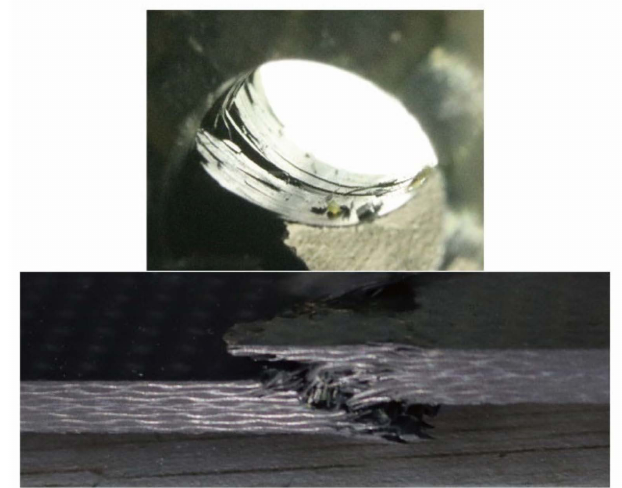
Figure 16. The ultimate failure of the CY-4-01